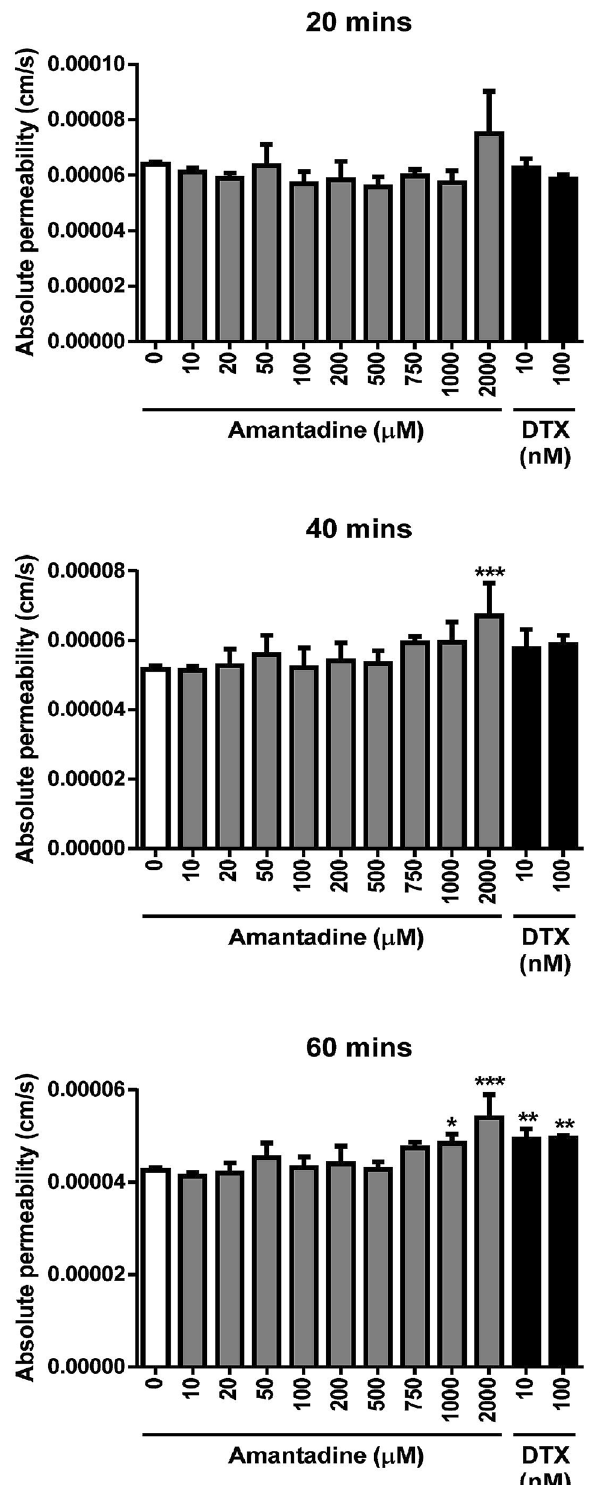
Figure 6. Effect of amantadine HCl on endothelial permeability in bovine cornea endothelial cells. BCE C/D-1b cells were seeded in the upper chamber of 0.4 μm transwell inserts and treated with different concentrations of amantadine HCl (0–2000 μM) or DTX (10 and 100 nM) for 24 h. Afterward, FITC-dextran (1 mg/mL) was added into the upper chamber, then the lower chamber media was collected after 0, 20, 40 or 60 min, and fluorescent intensity was measured (ex: 485 nm; em: 535 nm) using a fluorescence plate reader. The absolute permeability was presented as means ± SD of three independent experiments. The statistical significance was represented as follows: *p < 0.05, **p < 0.01 and ***p < 0.001 vs. untreated